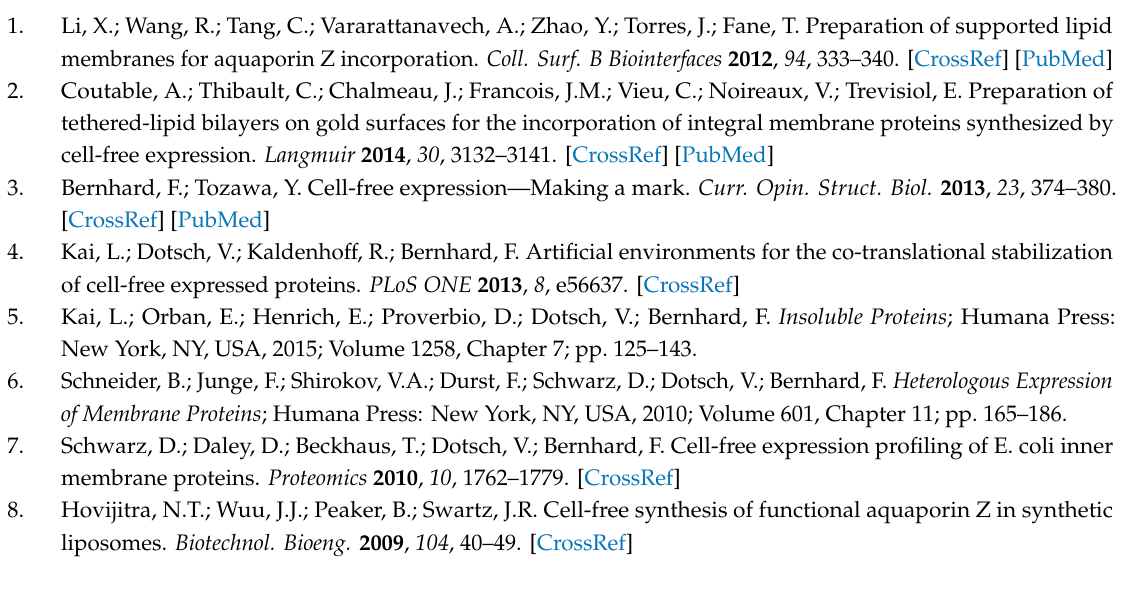
Figure S1: Titration of liposome with detergents